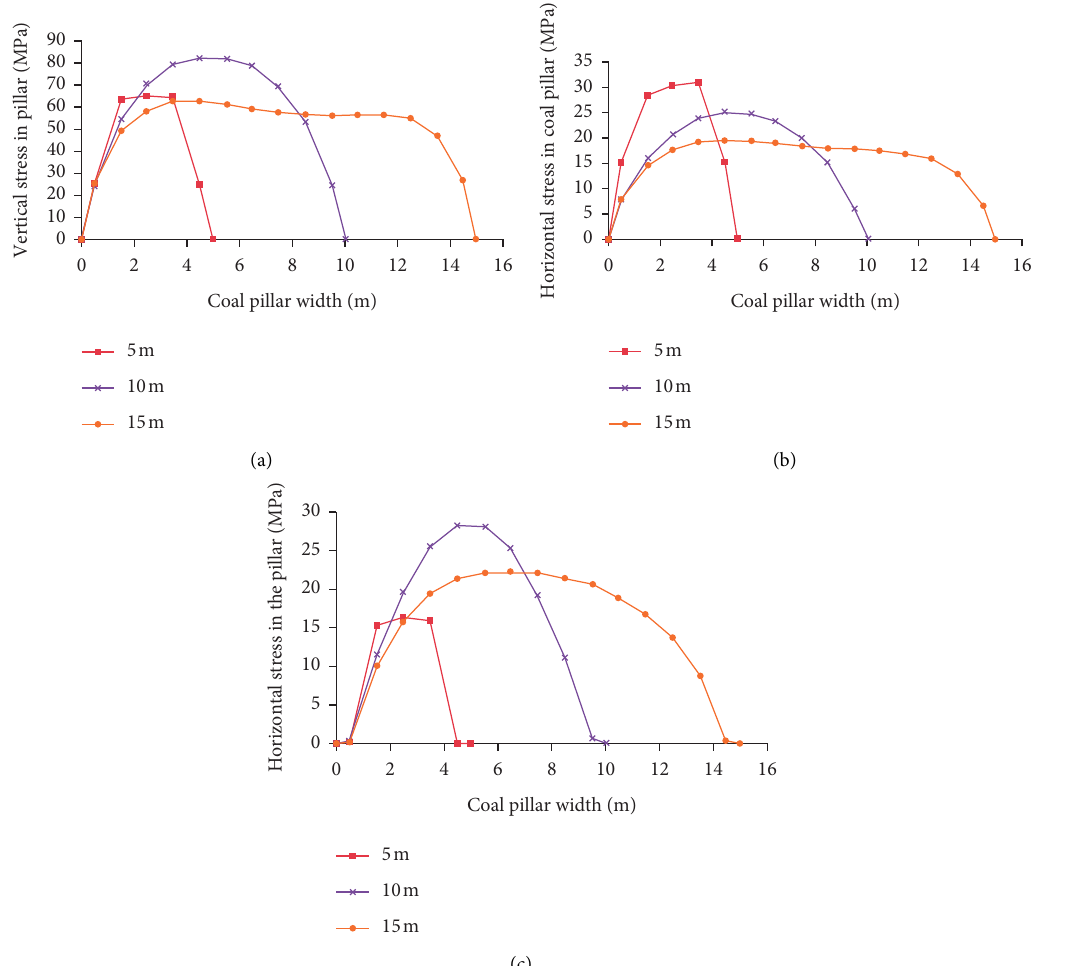
Figure 17: Stress distribution in coal pillar with different widths. (a) Vertical stress in pillar. (b) Horizontal stress in pillar (axial direction of parallel roadway). (c) Horizontal stress in pillar (vertical roadway axial direction).